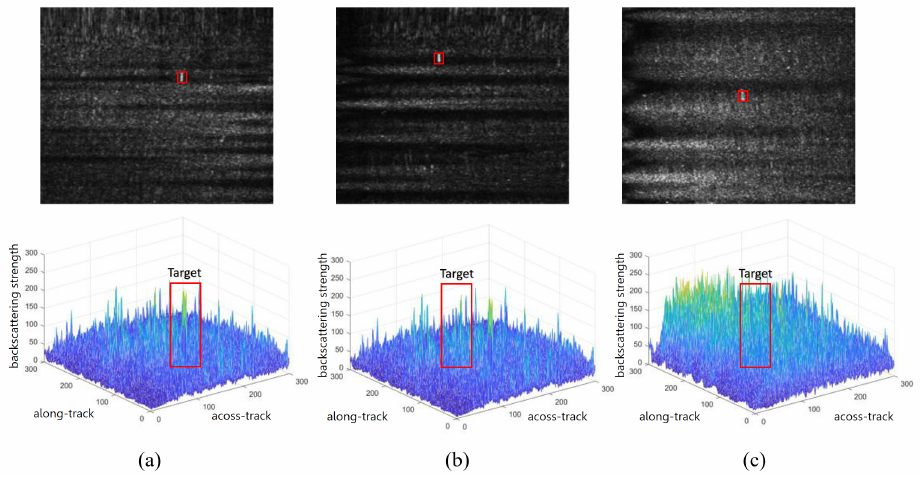
Figure 1. Side-scan sonar images and their 3D visualization. ( a – c ) The first row shows three side-scan sonar images and the second row shows the 3D visualization results of the corresponding images with different SCR conditions, in which the red rectangles are small target samples from different areas of the